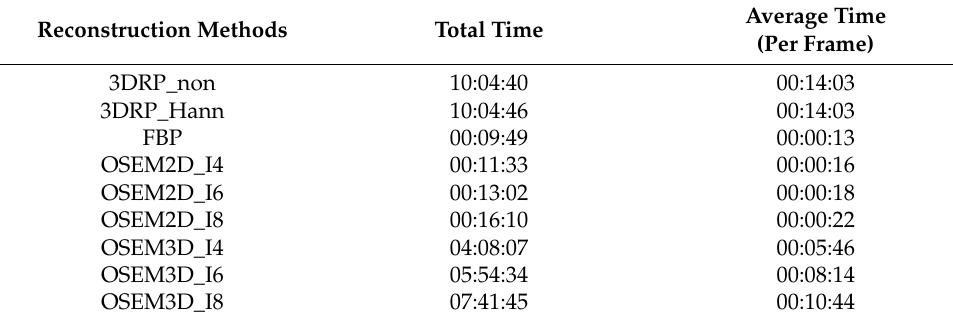
Table 1. Reconstruction times (hh:mm:ss) measured by embedded Inveon